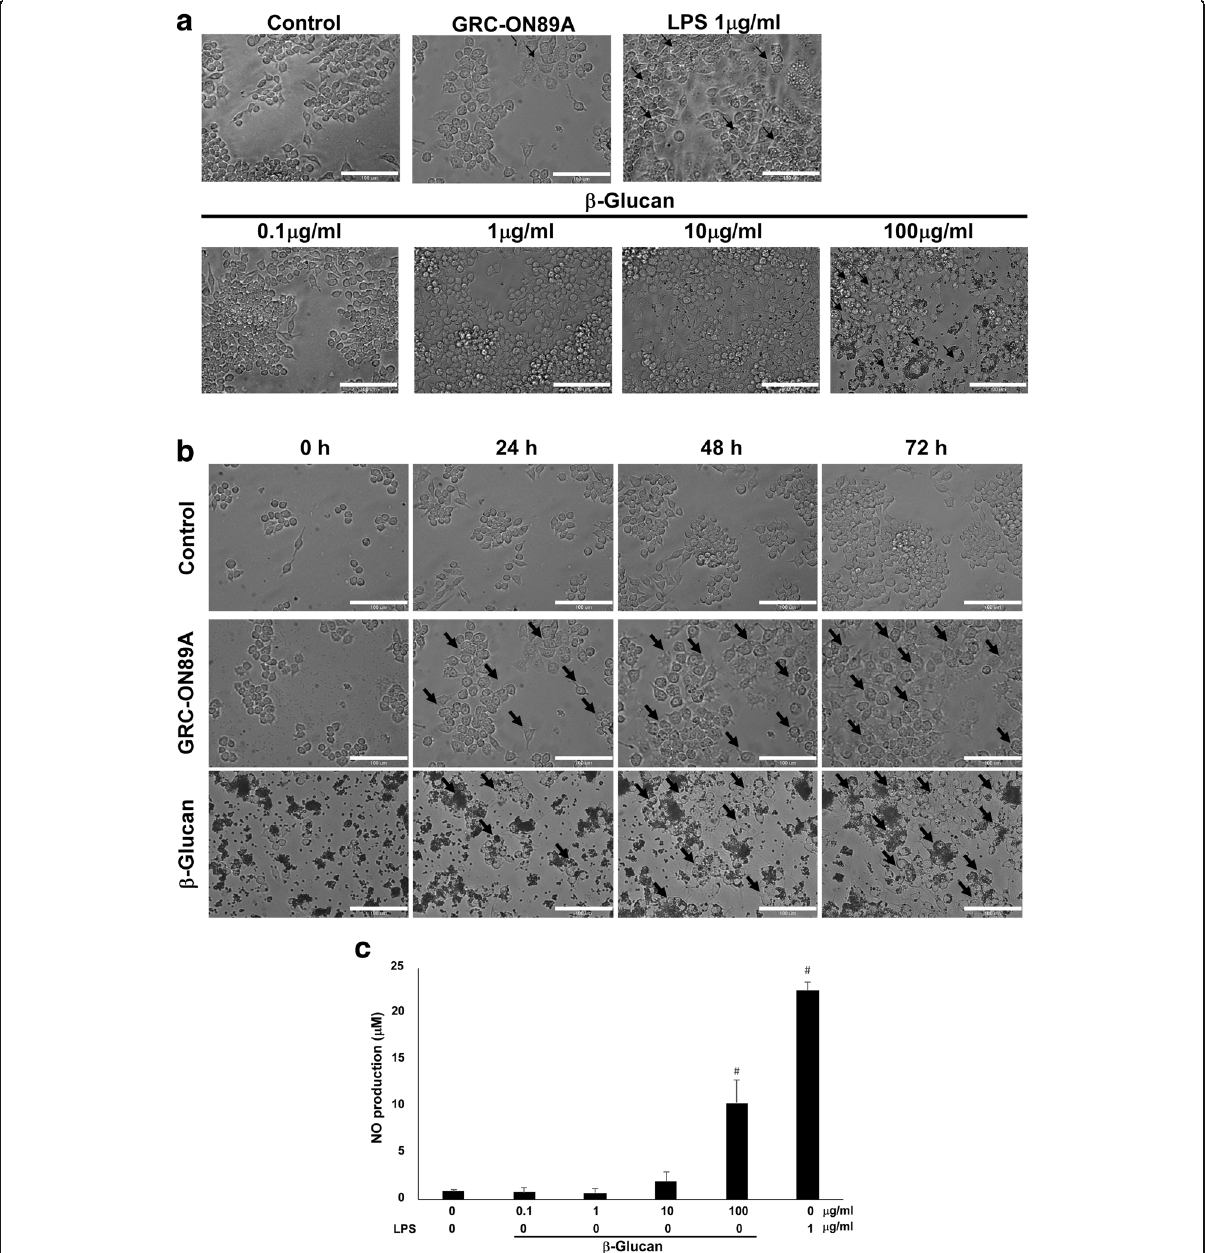
Fig. 7 Effect of GRC-ON89A and β -glucan on macrophage activity and morphology. a Cell morphological changes of β -glucan or GRC-ON89A treated RAW 264.7 cells. RAW 264.7 cells were treated with GRC-ON89A, β -glucan (0.1, 1, 10, 100 μ g/ml) or LPS (1 μ g/ml). Arrows mediated RAW264.7 cells with increased cellular size. b The cell morphology of RAW 264.7 by GRC-ON89A, β -glucan (100 μ g/ml) for 0, 24, 48, and 72 h was observed using Metamorph software for real time imaging (magnification, 200×). Arrows mediated RAW 264.7 cells with increased cellular size. c The level of NO production in RAW 264.7 cells by β -glucan. One-way ANOVA was used for comparison of group means, followed by Dunnett ’ s t -test ( # = p < 0.005 vs. control group). Each figure is representative of three independent experiments; Scale bars = 100 μ